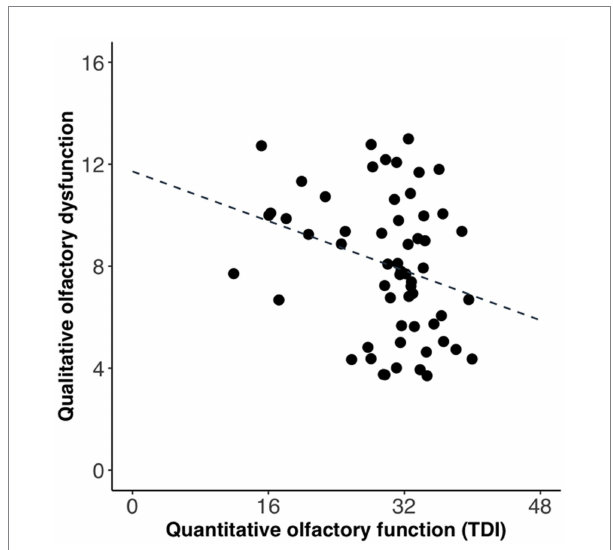
FIGURE 3 Relationship between qualitative olfactory dysfunction and quantitative olfactory function. Each data point represents one participant. Regression line is indicated by the intersected line. Scores are slightly jittered for visibility.